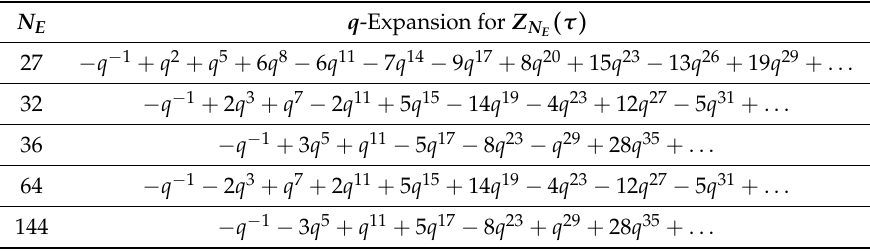
Table 2. Table of Z N